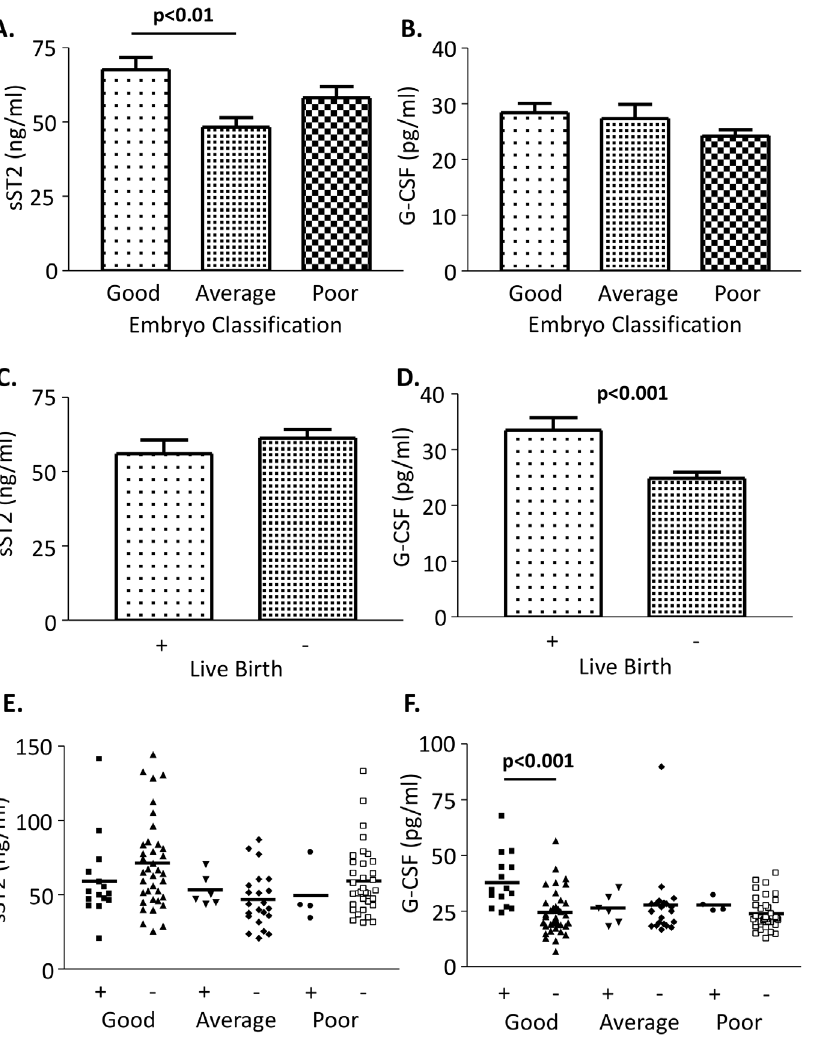
Figure 4. sST2 levels are lower in follicles which produce average quality embryos compared to good quality embryos but levels do not predict IVF success, unlike G-CSF. FFs with known embryo outcome were analysed for levels of sST2 and G-CSF. Embryos were graded good (n=52), average (n=28) or poor (n=38) and cytokine levels compared (A – sST2 and B – G-CSF). Levels of sST2 (C) and G-CSF (D) were compared to live birth outcome, ( + ; n=25)) or not ( 2 ; n=88), for all embryo grades, further designated by embryo quality (E and F respectively), good grade/ + (n=15); good grade/ 2 (n=37); average grade/ + (n=6); average grade/ 2 (n=22); poor grade/ + (n=4); poor grade/ 2 (n=34). Bars=mean 6 S.E.M (A–D) or scatter plot with bars=mean